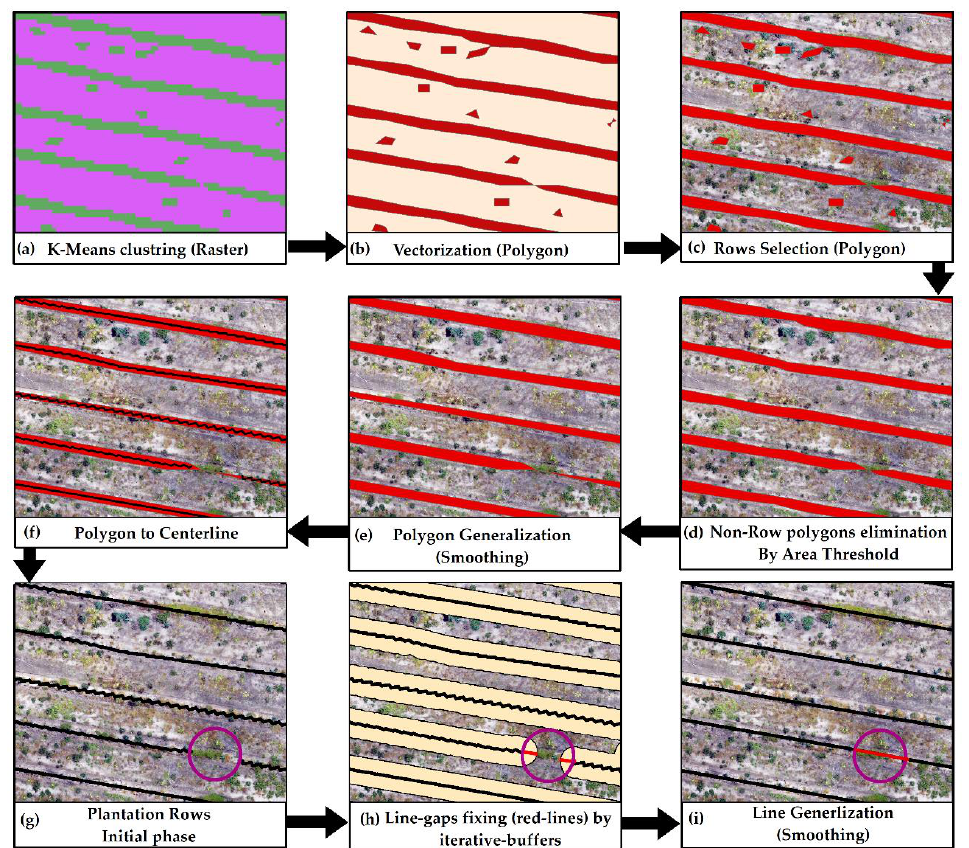
Figure 12. Plantation-row extraction process from raster data: ( a ) K-means classification image; ( b ) the process of vectorization to obtain polygons from pixel data; ( c ) separation of row polygons from non-row features: ( d ) elimination or non-row polygons from row polygons by an area threshold; ( e ) generalization of row polygons to smooth the shapes; (f) polygons to centerline conversion; ( g ) extracted plantation rows polylines with gaps; (h) iterative buffering to fix the gaps in plantation rows polylines; ( i ) generalization of polylines to obtain smooth and straight lines. The encircled red line segment represents the line gaps fixed by iterative buffers.